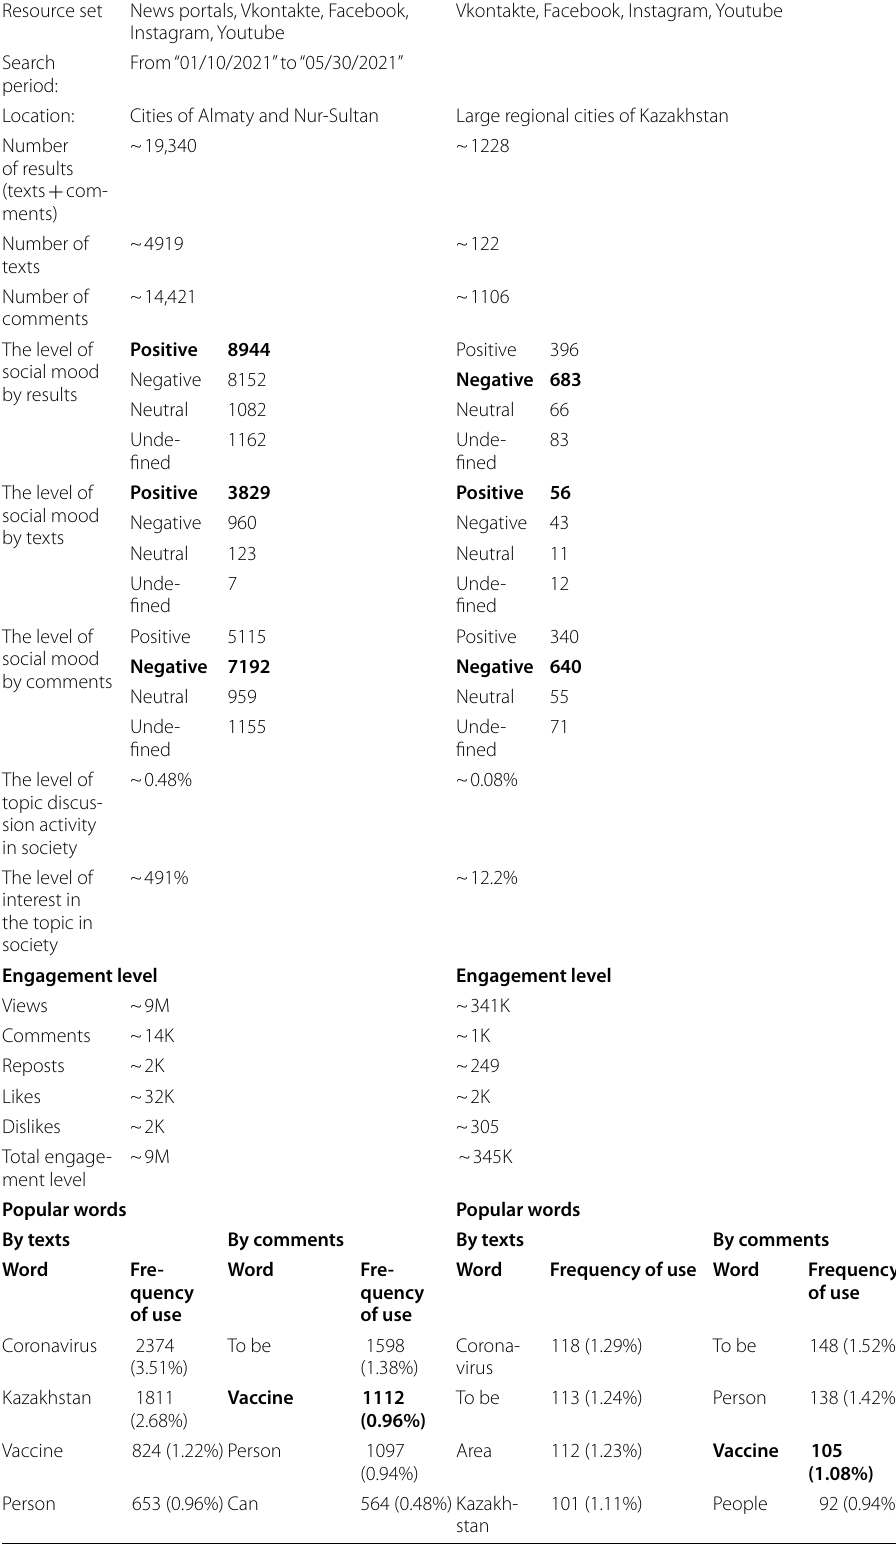
Table 12 Analysis by topics for period